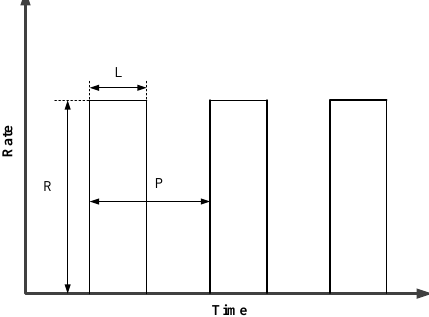
Figure 1. Model of low-rate denial of service (LDoS)